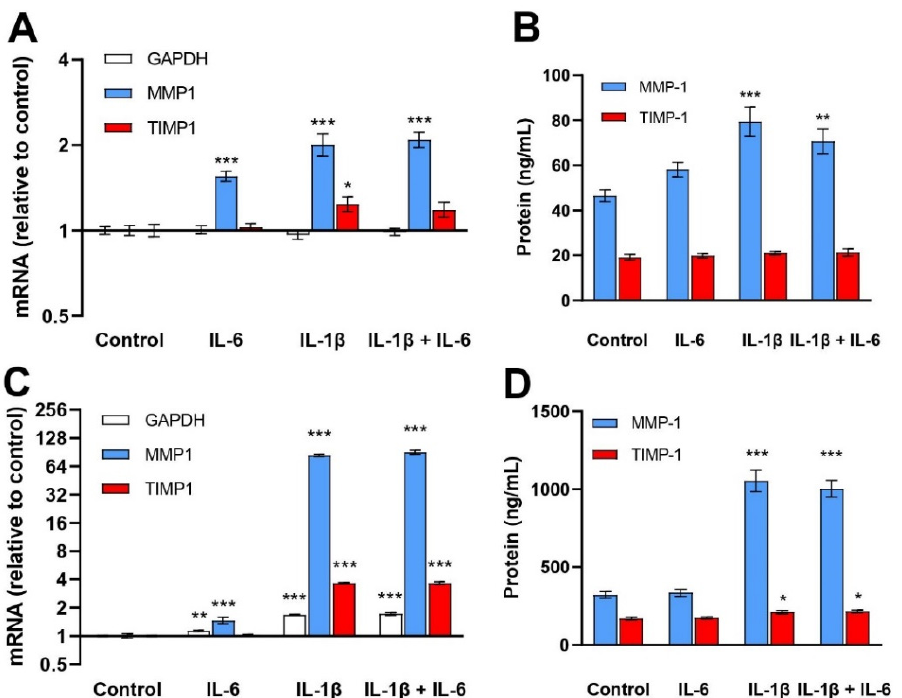
Figure 3. Effects of IL-6 (30 ng/mL) and IL-1 β (1 ng/mL) treatment of NHEKs ( A , B ) and NHDFs ( C , D ) on MMP1 and TIMP1 mRNA ( A , C ) and protein media levels of MMP-1 and TIMP-1 ( B , D ). mRNA levels were determined by RT–qPCR and normalized to RPLP0 , expressed as FC relative to control-treated NHEKs and NHDFs. The geometric mean ± back-transformed SEM of 6 replicates is shown ( A , C ). MMP-1 and TIMP-1 protein levels were determined by ELISA. The mean ± SEM of 6 replicates is shown ( B , D ). * p < 0.05, ** p < 0.01, *** p < 0.001 vs. control.